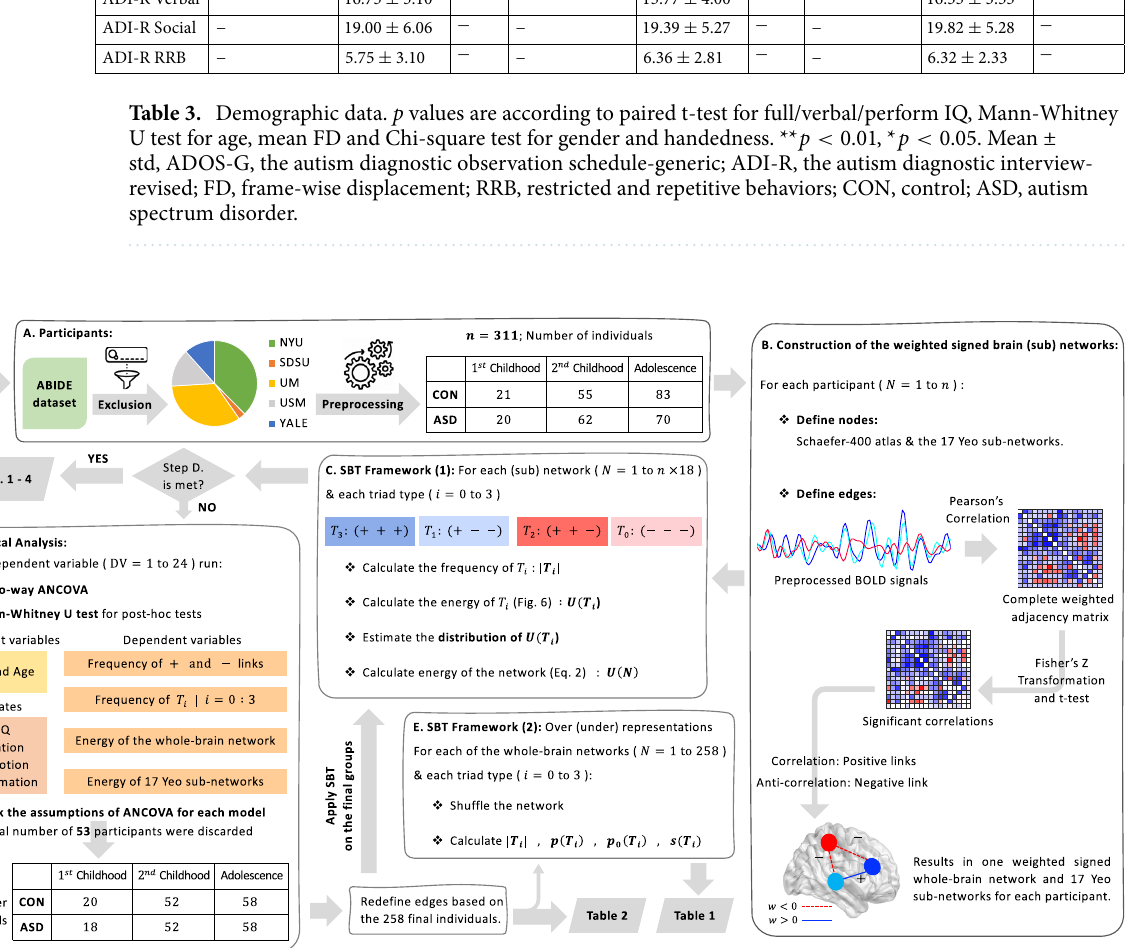
Figure 5. Graphical abstract ( A ) After preprocessing, 311 individuals (159 and 152 in CON and ASD groups, respectively) have been included. ( B ) Brain construction was based on Schaefer-400 atlas as nodes and significant Pearson’s correlations as edges. ( C , E ) Procedures as has been defined in the context of SBT. D Statistical analysis for comparing group means. For head motion and site information covariates, frame-wise displacement and site codes have been used, respectively. As a results of applying ANCOVA’s assumption 53 individuals were discarded. After excluding these individuals, network’s edges have been redefined based on the remaining 258 participants. Step C has been reapplied on the final networks. BrainNet Viewer 1.63 40 (nitrc .org/ proje cts/bnv) has been used for visualization of the brain networks. n, number of individuals; | T i | , total number of T i ; p ( T i ) , fraction of T i ; p 0 ( T i ) , fraction of T i in the null model; s ( T i ) , the amount of surprise; SBT, structural balance theory; NYU, New York University; SDSU, San Diego State University; UM, University of Michigan; USM, University of Utah School of Medicine; YALE, Yale Child Study Center; CON, Control; ASD, autism spectrum